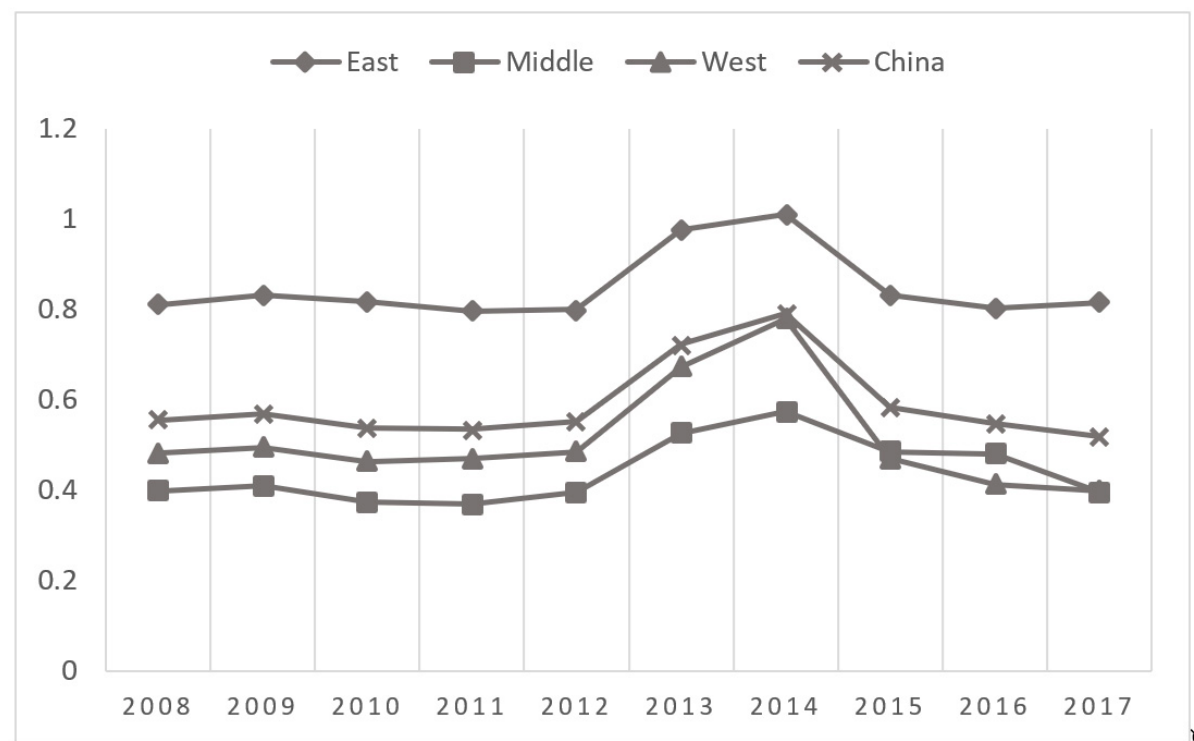
Figure 1. The development trend of green economic efficiency from 2008 to 2017. In terms of the spatial distribution of green economic efficiency (see Figure 2), the eastern region is, overall, higher than the national average, while the eastern and western regions are higher than the middle. The green economic efficiency of the three regions from west to the east shows a V shape, with high values on both sides and low in the middle. In terms of rank by green economic efficiency, seven of the top 10 are located in the eastern part, while seven of the bottom 10 are in the western region. All the provinces (except Qinghai) with green economic efficiency greater than 1 belong to coastal areas distributed in the Yangtze River Delta, the Pearl River Delta, and the Bohai Rim economic circle